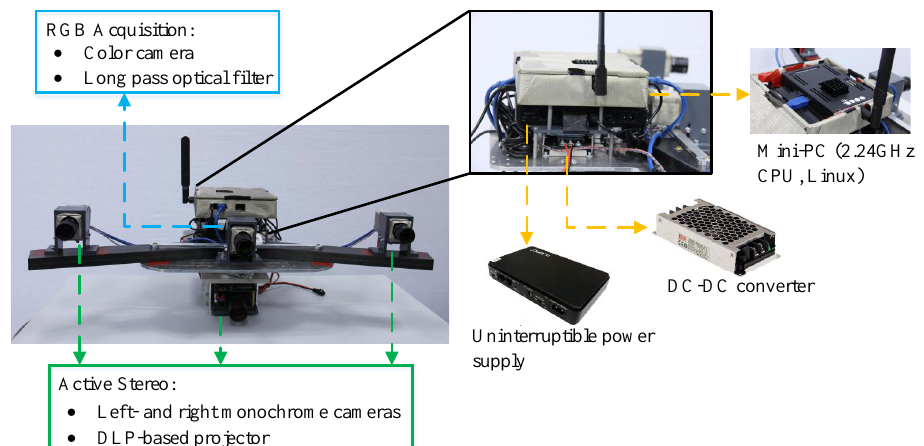
Figure 1. Active triple-camera experimental setup. Left- and right monochrome cameras with the projector constitute an active stereo system, and the middle color camera captures the object textures with a long pass optical filter (useful range: 510–1100 nm).